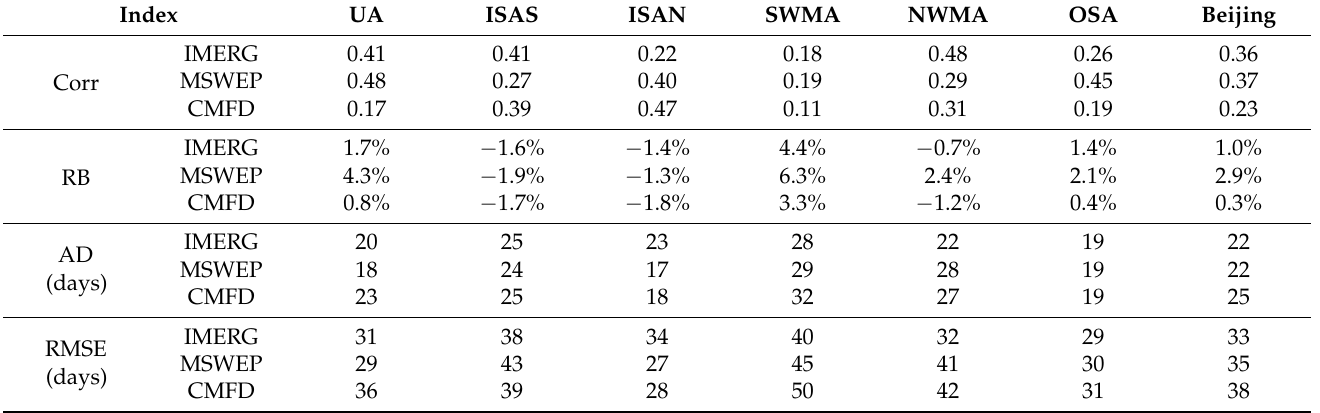
Figure 5. Boxplots for the four percentile and max indices: ( a ) RX1day, ( b ) RX5day, ( c ) R95p, and ( d ) R95pTOT for the rainfall station data and the three satellite-derived precipitation products at 36 stations. Table 6. Accuracy evaluation of the occurrence date of RX1day detection by the rainfall station and satellite-derived precipitation products for the period